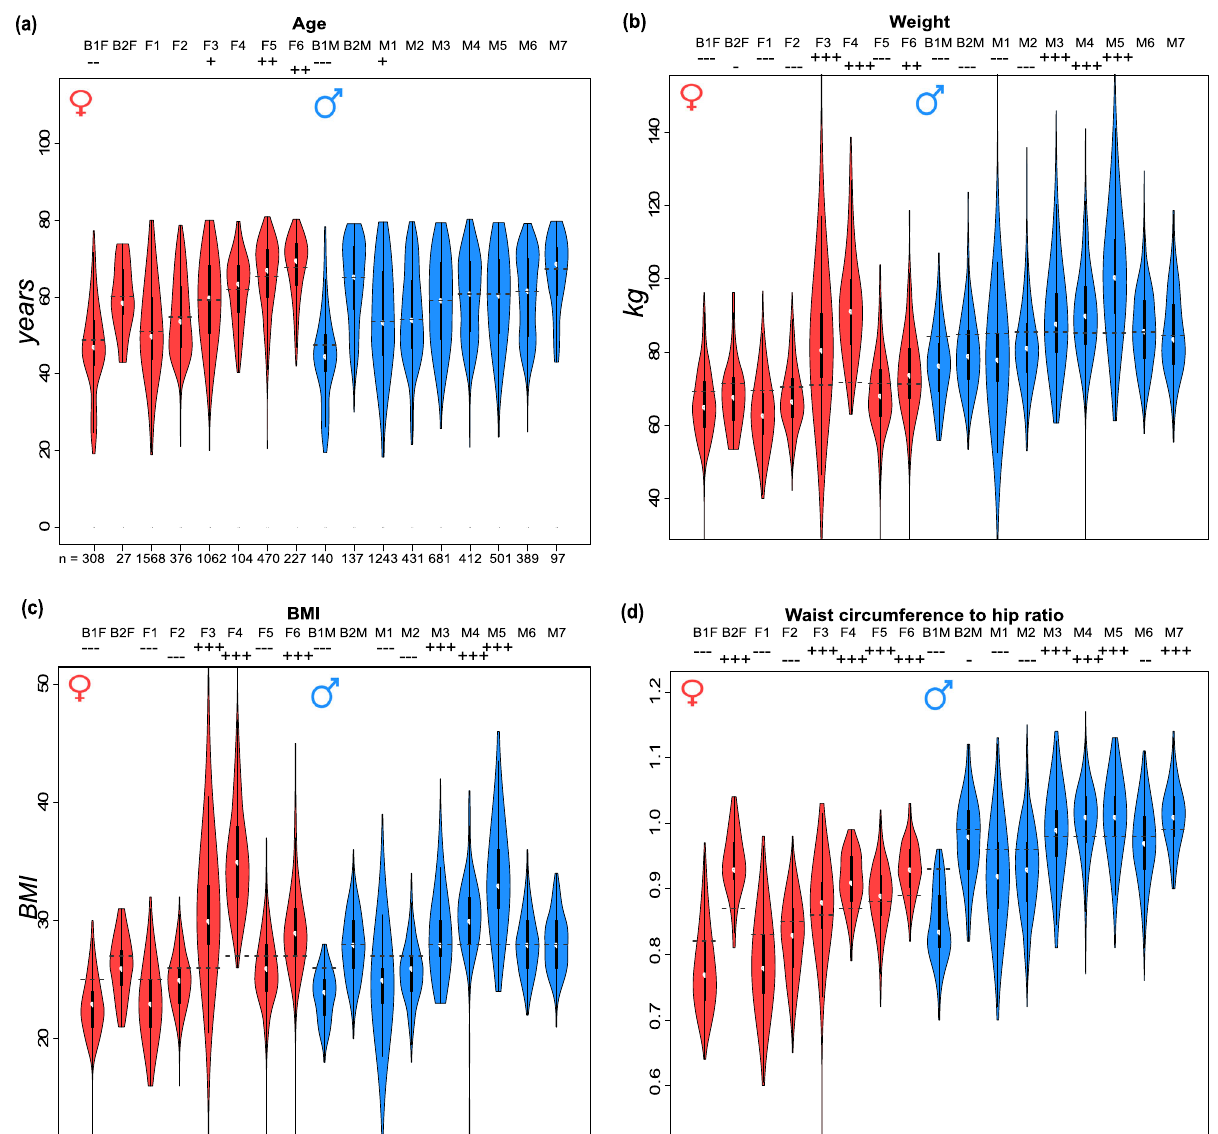
Fig. 3 Anthropometric parameters of the body types. a The age dependence of F-types (F1 – F6) is more pronounced than that for men (M1 – M7). b , c F3 and F4 are obese types among the F-types with a high variability of F3, while M5 is the most obese M-type. d The WTH data do not re fl ect these characteristics. P values of differences between the body types groups and age-matched reference groups are indicated as signs in the head line of each plot ( p < 0.1 ( + / − ), <0.01 ( ++ / – ), and <0.001 ( +++ / −−−